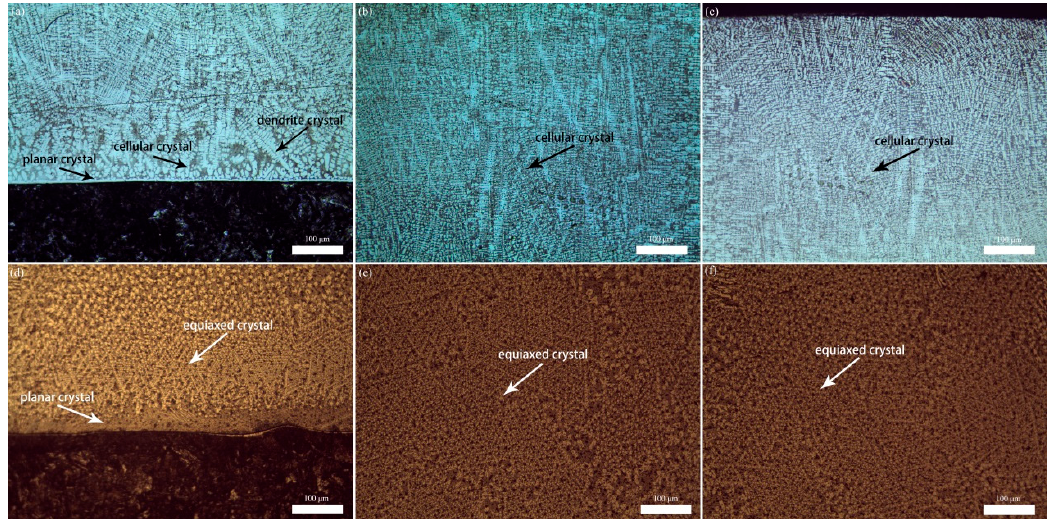
Figure 5. ( a – c ) Bottom, middle, and upper region of Coating 1 and ( d – f ) bottom, middle, and upper region of Coating 2.